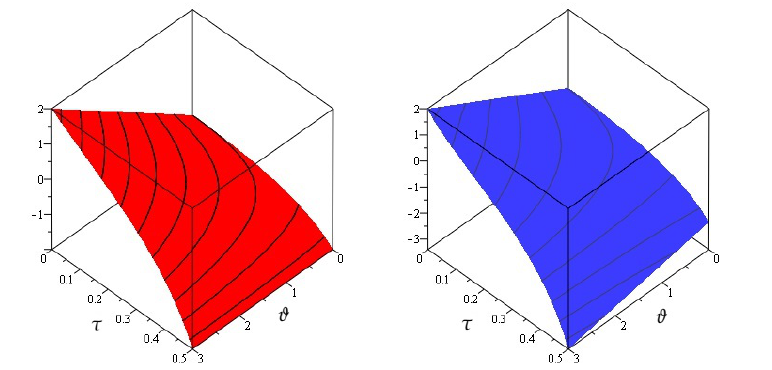
Figure 15. The different fractional-order of (cid:36) of ν ( ϑ , ζ , z , τ ) of Example 4.